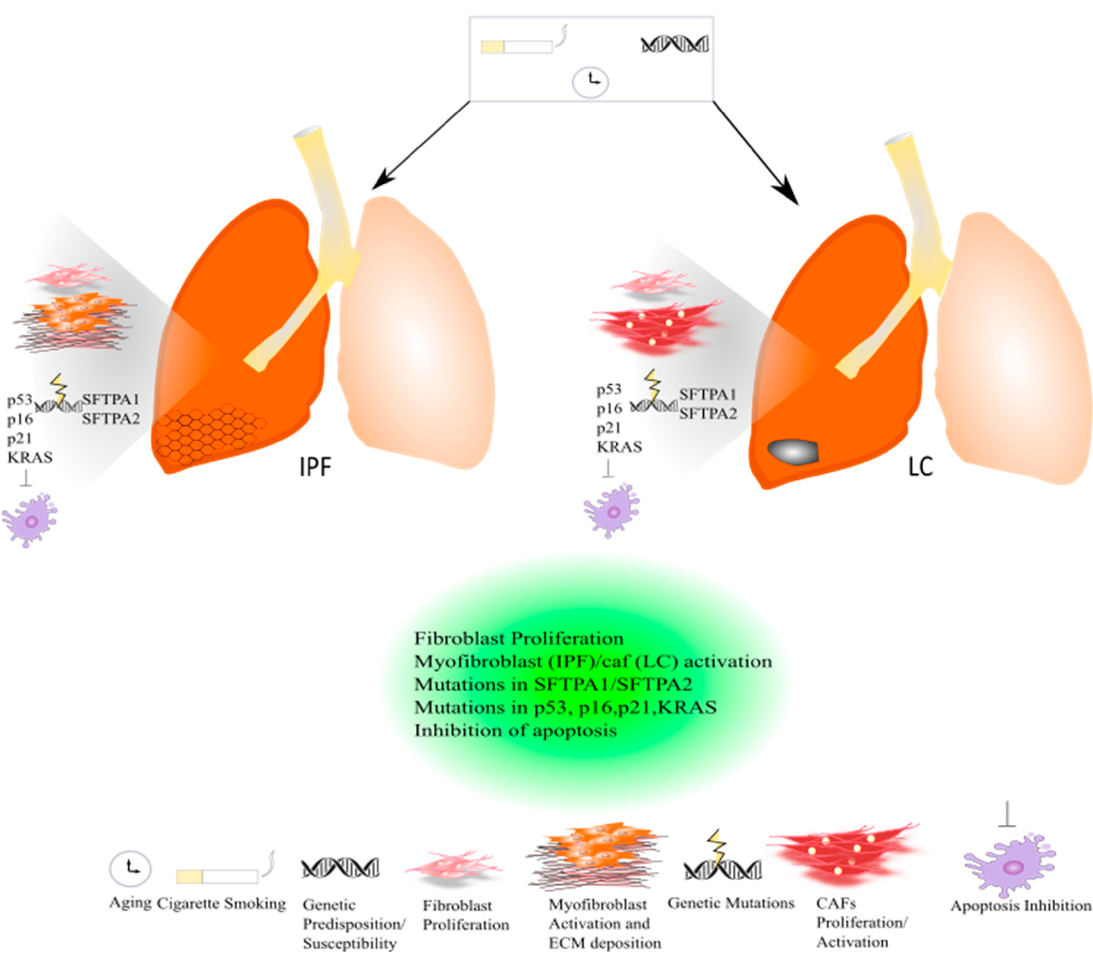
Figure 1. Common pathogenic mechanisms between lung cancer and IPF.